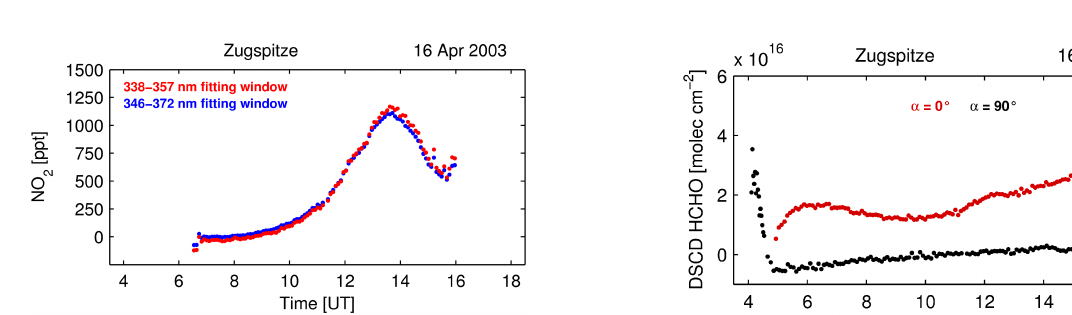
at Zugspitze as a function of AOD and multi-year-averaged (2004–2009) monthly means of X NO Figure 9. Monthly averaged X NO 2 Espejo as a function of spatially averaged fire radiative power (FRP) over selected regions (see Table 3). The standard deviation of daily and monthly means is given for Zugspitze and Pico Espejo (see Table 3).